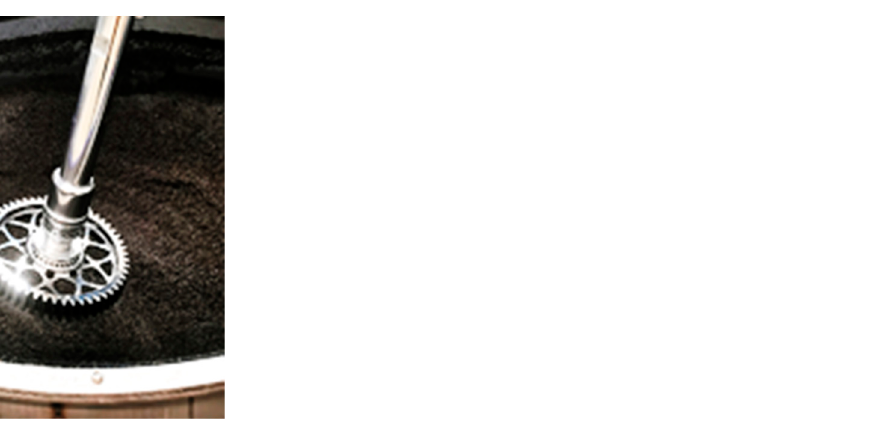
Figure 5. Spur gear as the workpiece mounted on Stream Finishing machine spindle [17].